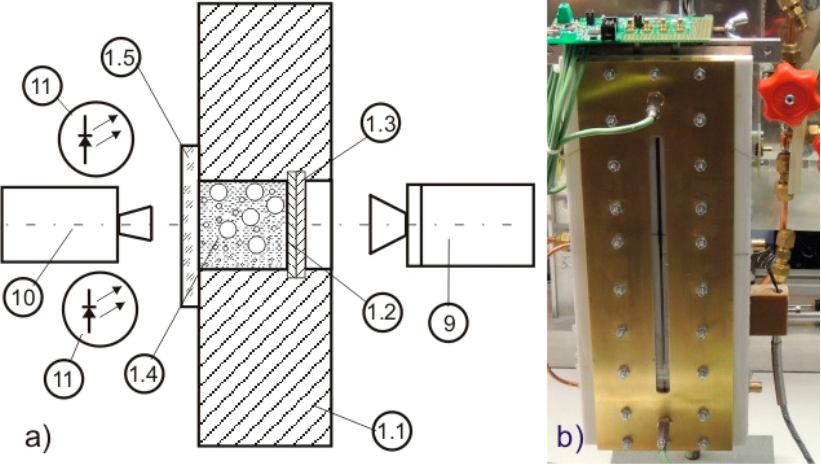
Figure 2. ( a ) The cross-section of the test section with the mini-channel and the position of the infrared camera and high-speed camera and